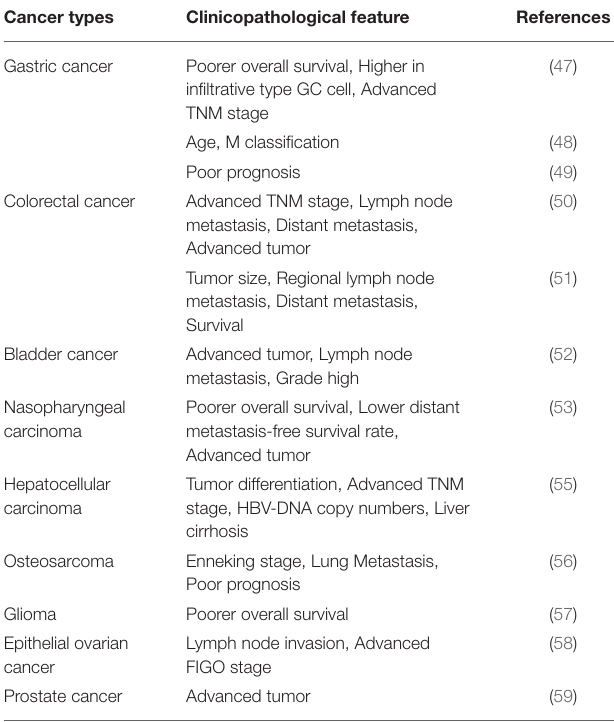
TABLE 2 | Clinical features associated with circHIPK3 in multiple human